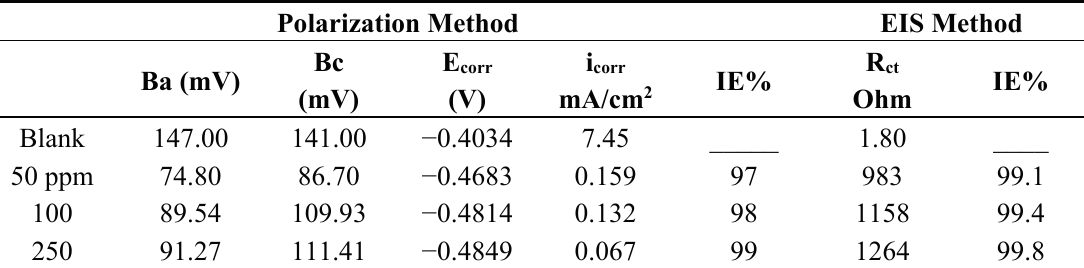
Figure 6. Polarization curves for steel in 1 M HCl solution containing different AA-Na/magnetite composites concentrations. Table 1. Inhibition efficiency values for steel in 1 M HCl with different concentrations of AA-Na/magnetite composites calculated by polarization and EIS